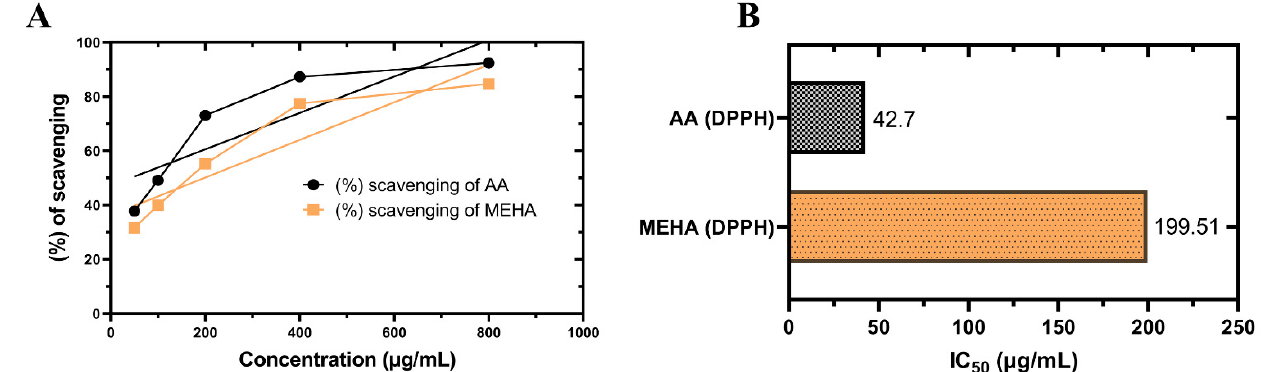
Figure 1. DPPH free radical scavenging activity of MEHA compared with the reference standard ascorbic acid (AA). ( A ) Percentage of DPPH free radical scavenging activity by different concentrations of the MEHA and reference standard AA. ( B ) IC 50 values for DPPH free radical scavenging activity of MEHA and AA. Values are expressed as mean ± SEM of three independent experiments. MEHA refers to methanol extract of Homalomena aromatica leaves. DPPH: 1,1-diphenyl-2-picrylhydrazyl radical.